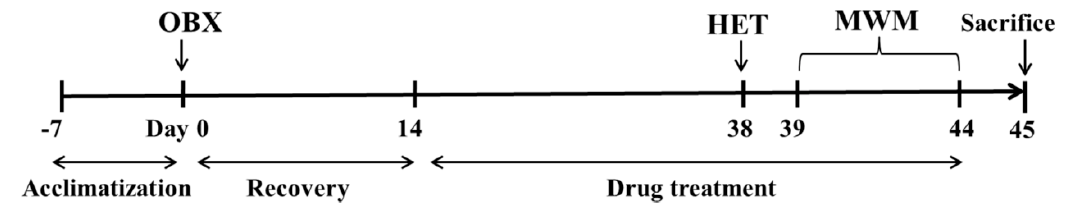
Figure 1. Diagram of the experimental protocol. HET, Hyperemotionality Test. MWM, Morris Water Maze. OBX, Olfactory Bulbectomy.